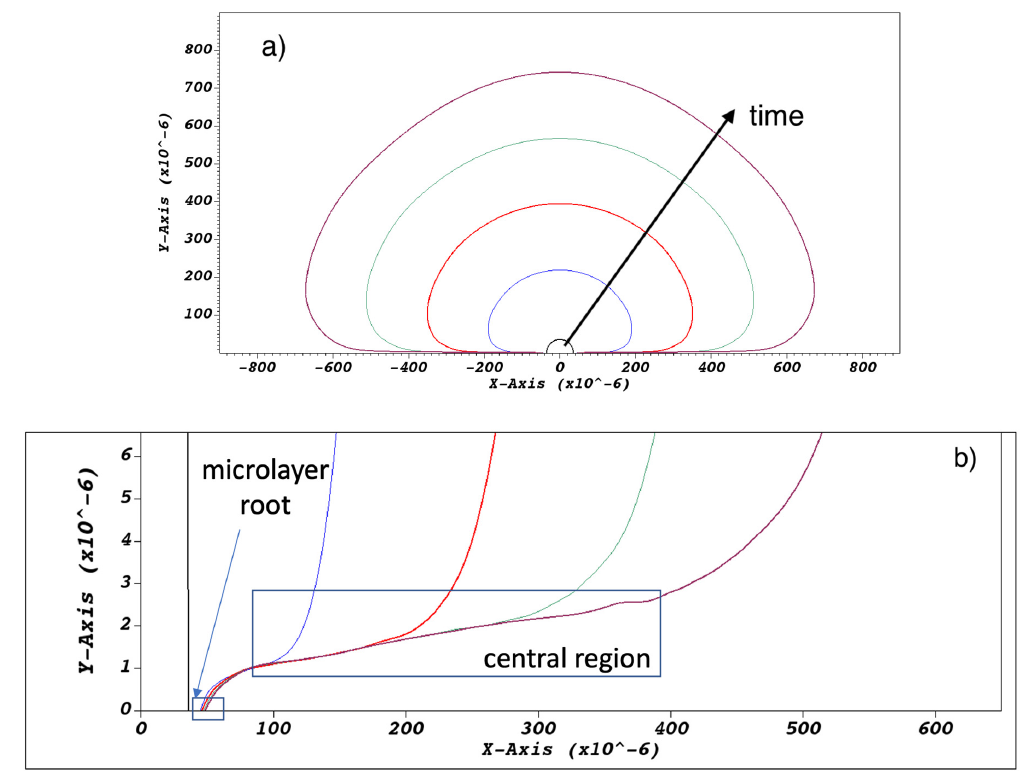
Figure 6. ( a ) Typical modelled bubble shapes at a sequence of times, namely at t = 0 and at 0.05, 0.1, 0.15, and 0.2 ms into bubble growth. Magnification ( b ) of the near-wall region shows the microlayer being left behind on the no-slip wall boundary.